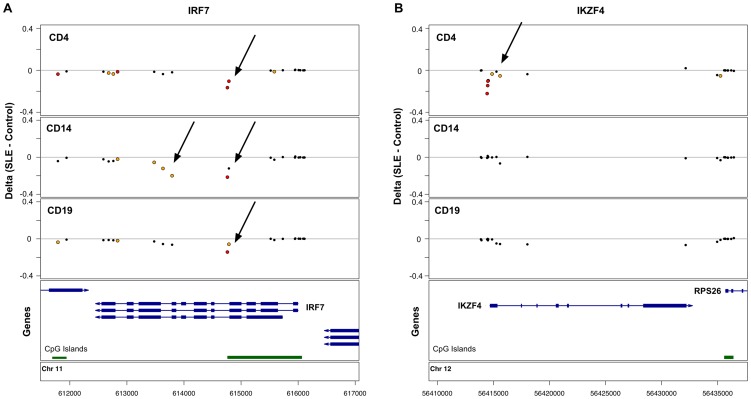
Common and cell type-specific DNA methylation changes in SLE.Differences in mean methylation between SLE and controls are plotted for each cell type at each probe near two genes. A. The IRF7 gene shows hypomethylation across all three cell-types at a CpG island, plus monocyte-specific hypomethylation further into the gene body. B. The IKZF4 gene shows T-cell-specific hypomethylation at the 5′ end of the gene. Red dots indicate p<1×10−8. Yellow dots indicate FDR<1%.